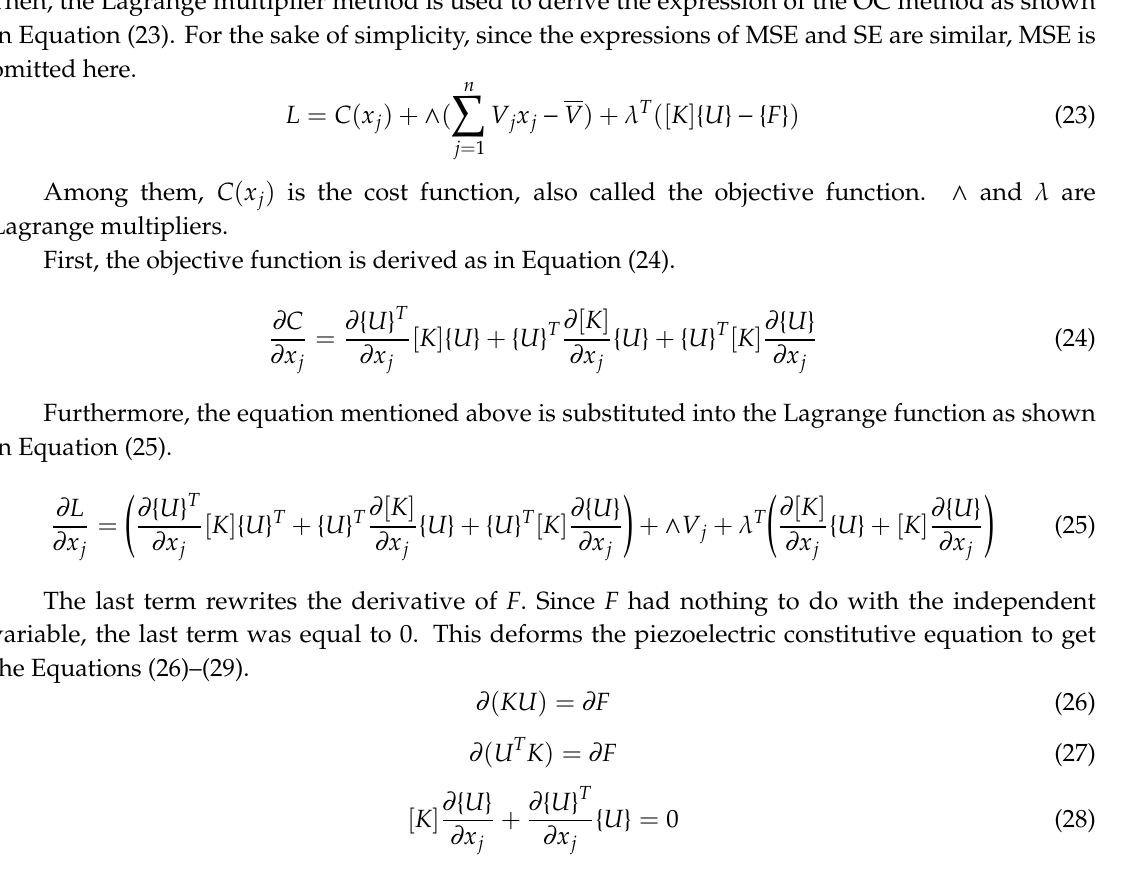
Figure 4. Individual units and their numbers.